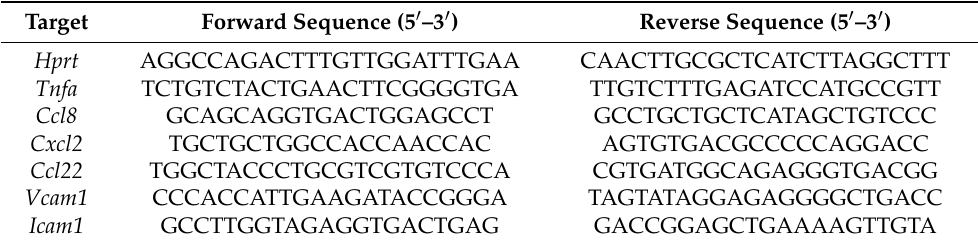
Table 1. List of primers for